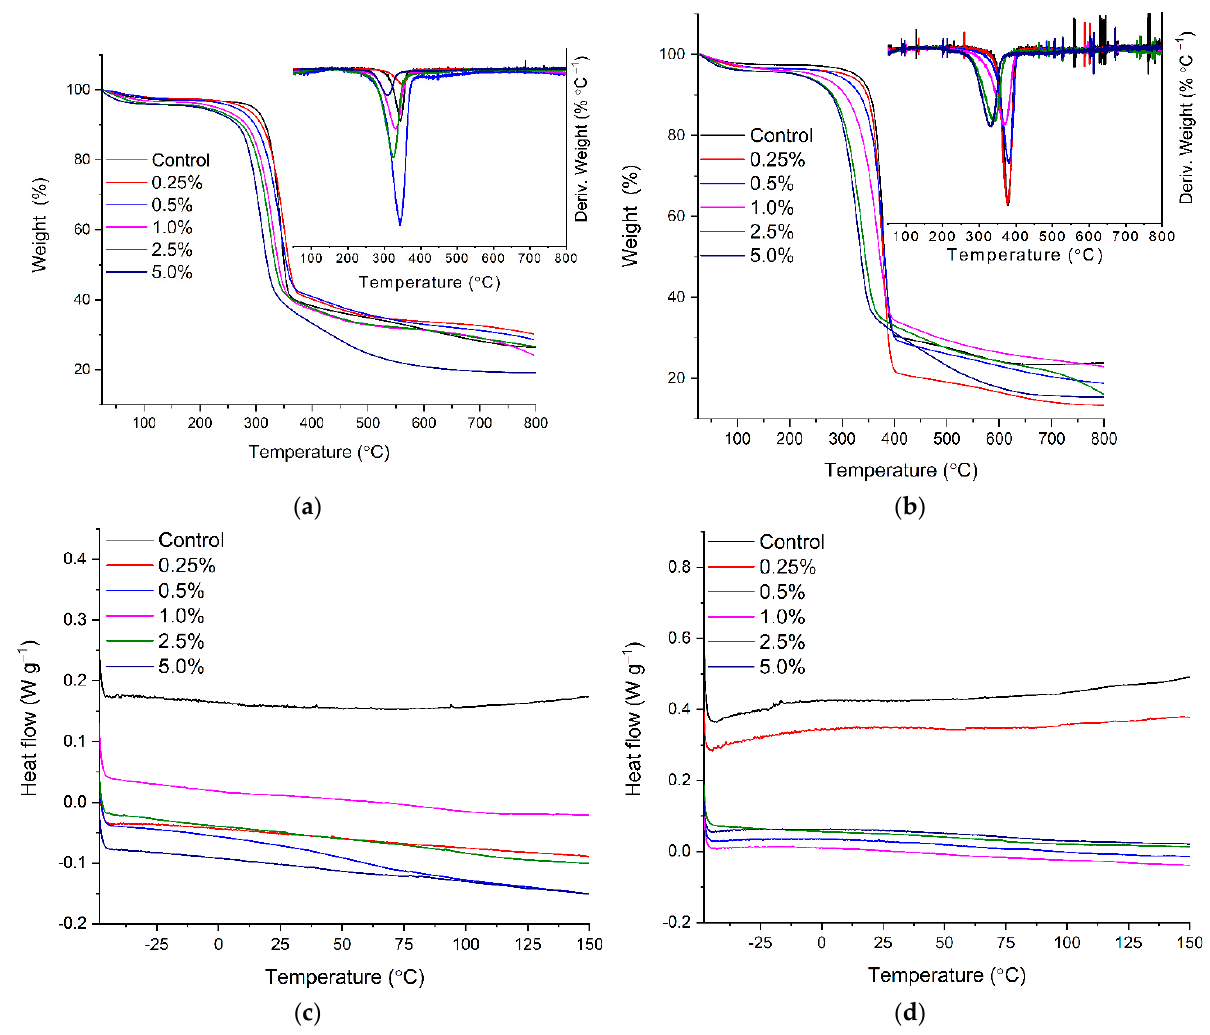
Figure 3. The TGA and DSC analysis results for composites prepared with different concentrations of CA and used ferrites particles NiFe 2 O 4 ( a , c ) and MgFe 2 O 4 ( b , d ). Table 1. Thermal stability (TGA) of prepared BC-CA-based magnetic